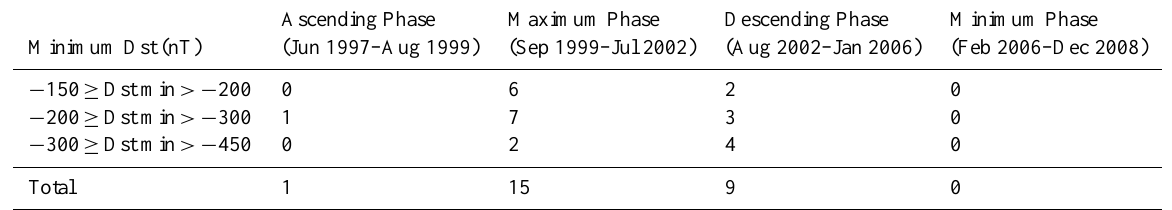
Table 2. The distribution of the major geomagnetic storms according to the phase of solar cycle and minimum Dst values.